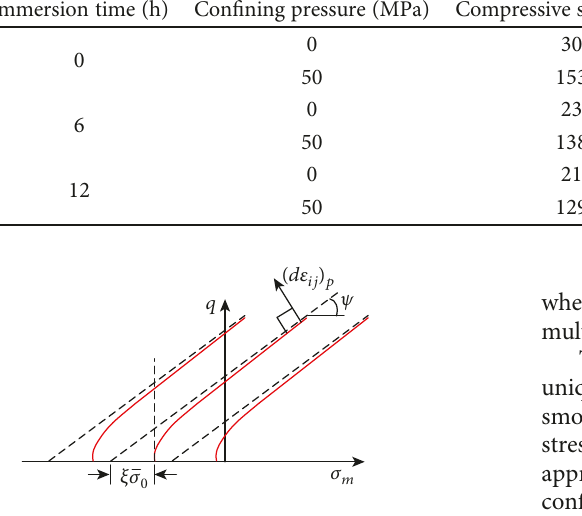
Figure 6: A family of fl ow potentials in the meridional stress